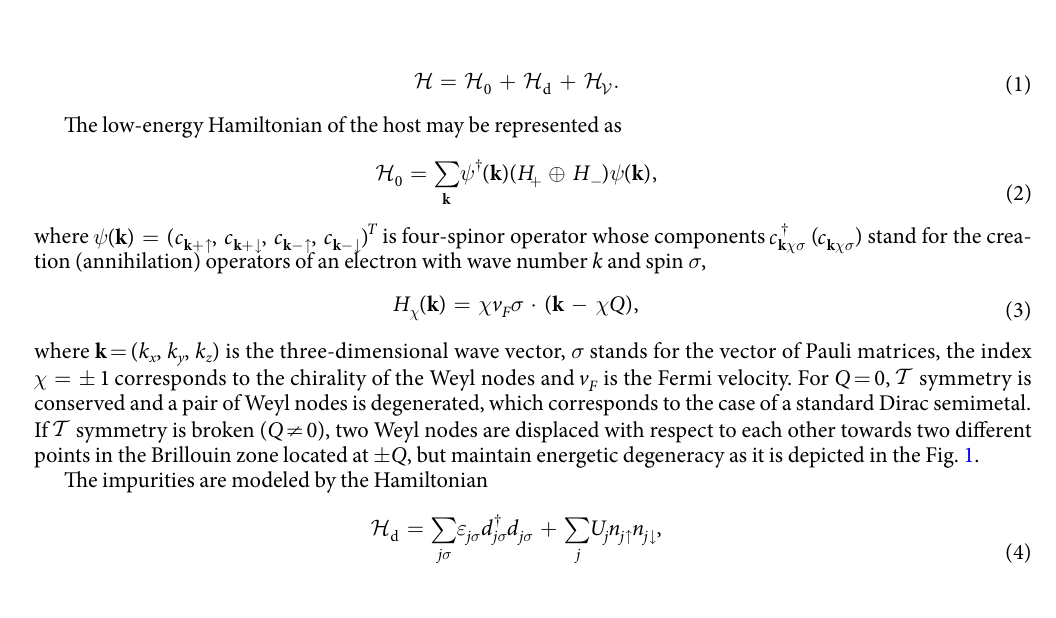
Figure 1. Panel (a) Sketch of the proposed setup. Two impurities are embedded in a 3D semimetal of Dirac or Weyl type. The density of electrons forming molecular orbitals can be probed by an STM-tip. Panels (b,c) show low energy band structure for Dirac and  -breaking Weyl semimetals with two Weyl nodes located at ± Q i , i = x , y , z . The blue color of the lower cones indicates the filling of the valence bands, black dotted line is the Fermi energy set at ε F = 0 and red dotted line corresponds to the single-particle energy of the